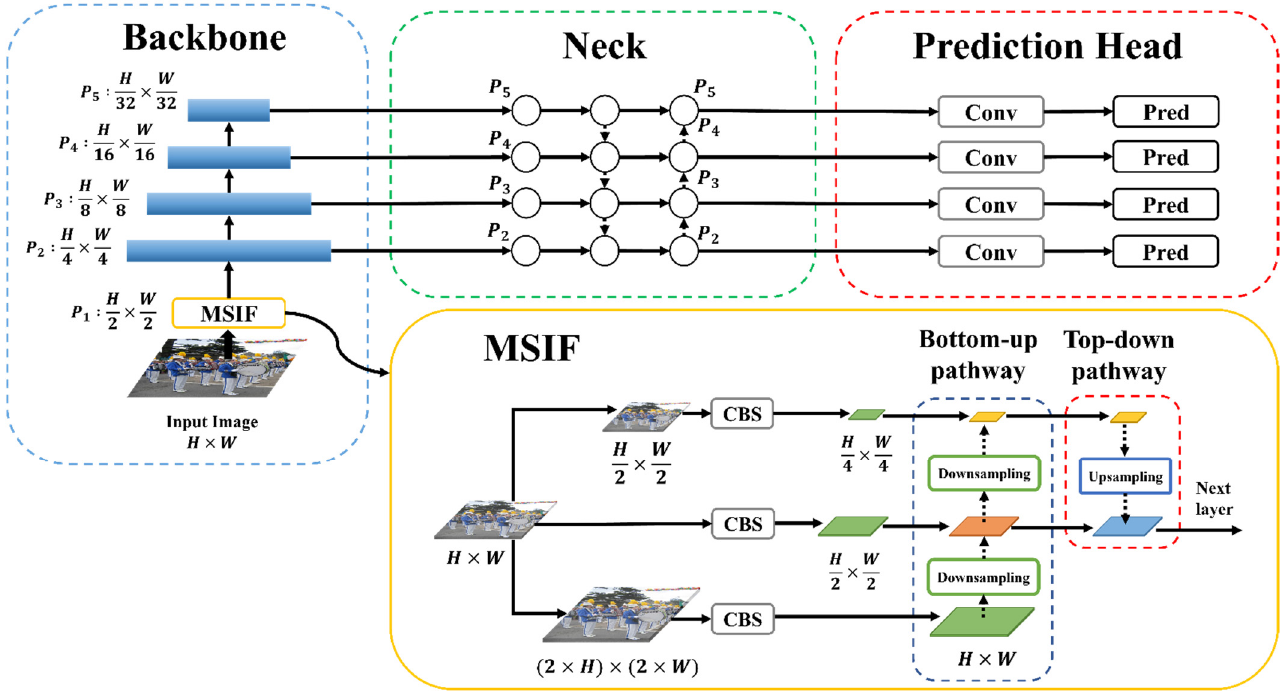
Figure 1. The overall structure of the proposed FAFD, where H and W are the height and width of the input image, respectively.